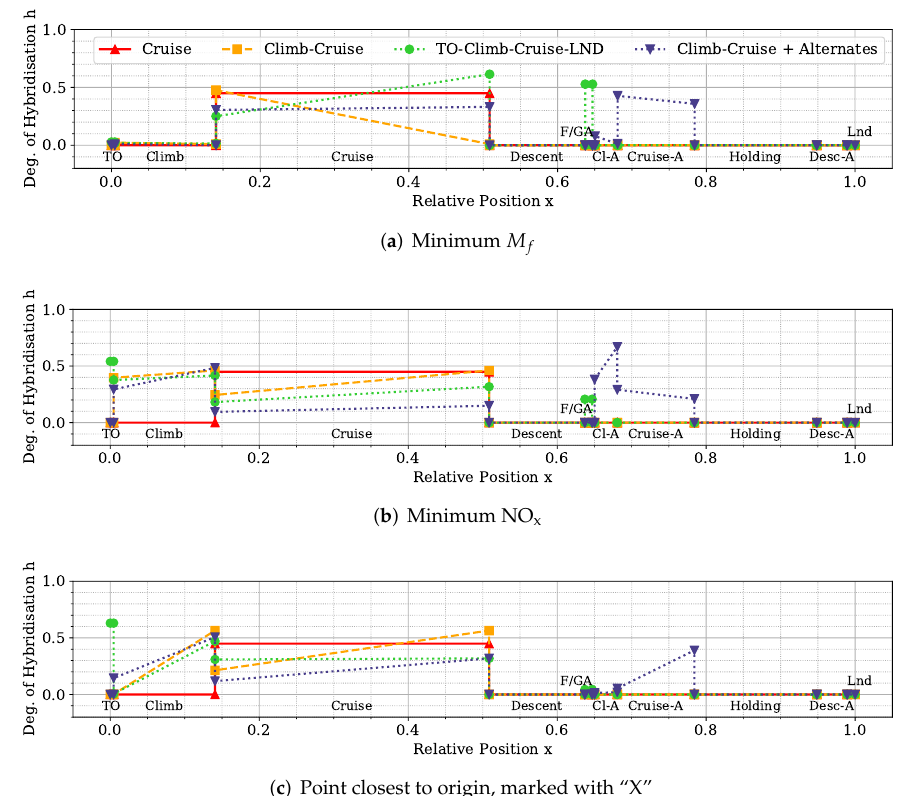
Figure A6. Test 4 optimal energy management strategies.